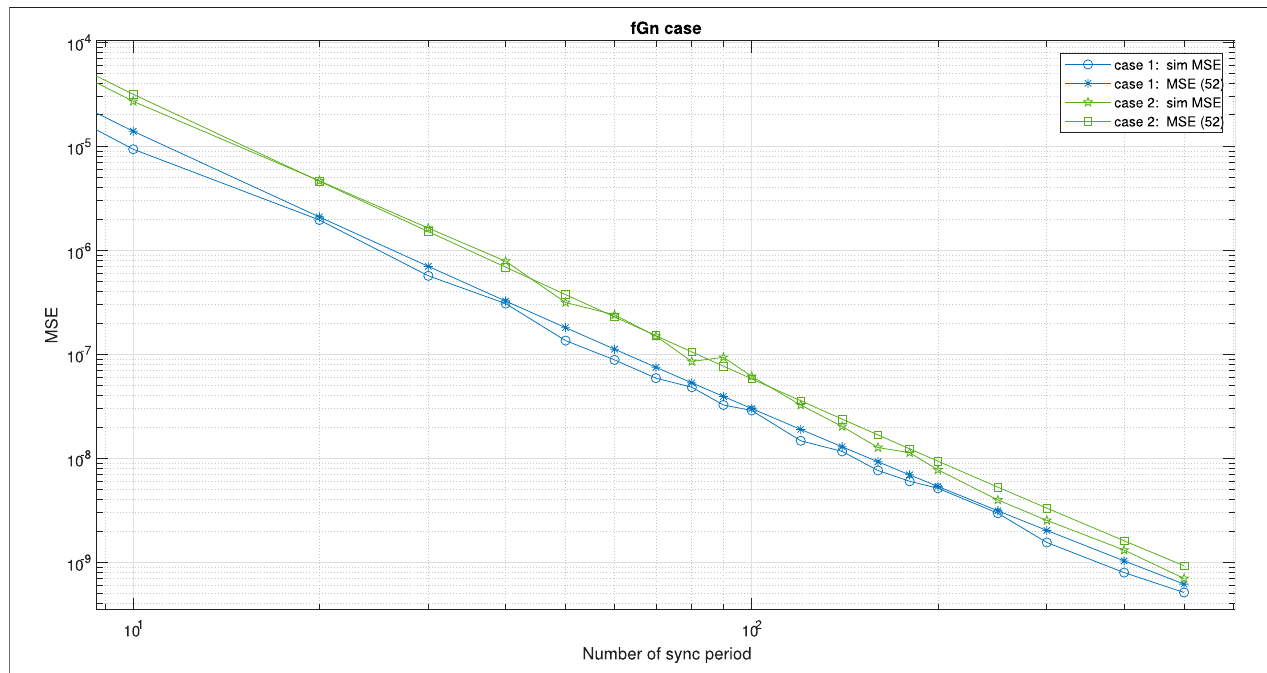
FIGURE9| PerformancecomparisonbetweenthenewproposedexpressionfortheMSE Eq.52 withthoseobtainedfromthesimulatedclockskewestimator Eq.3 for the fGn case (denoted here as sim MSE), where the forward and reverse PDV variances are different. α (cid:1) 50 ppm , Q (cid:1) 5 ms , T syn (cid:1) 15 . 6 ms ( 64 packet d sm (cid:1) 5.5 ms , H (cid:1) 0.6. case 1 : σ ω